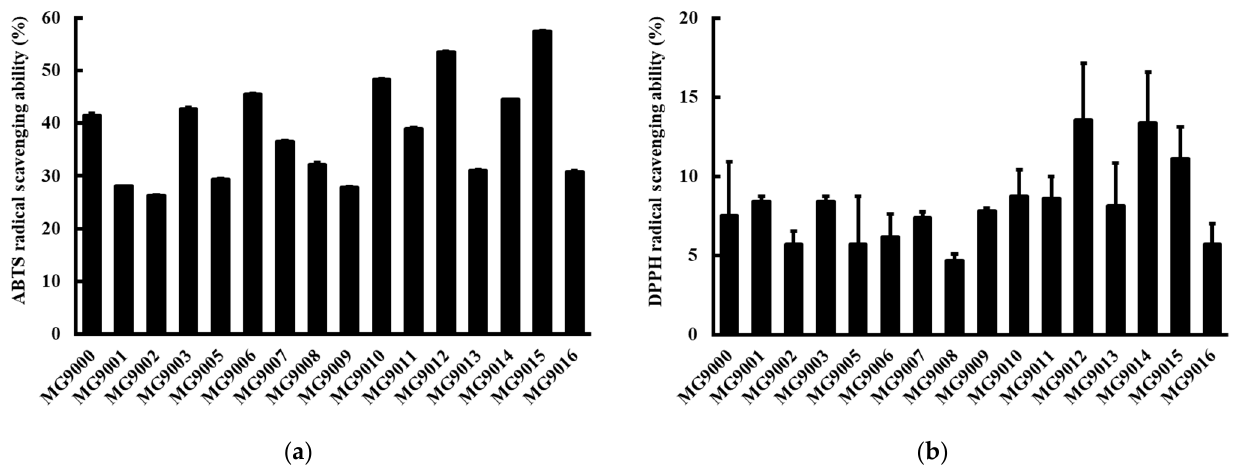
Figure 1. ABTS and DPPH radical scavenging activities of 16 isolated bacterial strains. ( a ) ABTS radical scavenging activity of 16 bacterial isolates; ( b ) DPPH radical scavenging activity of 16 bacterial isolates. Values represent the mean ± SEM ( n = 3).